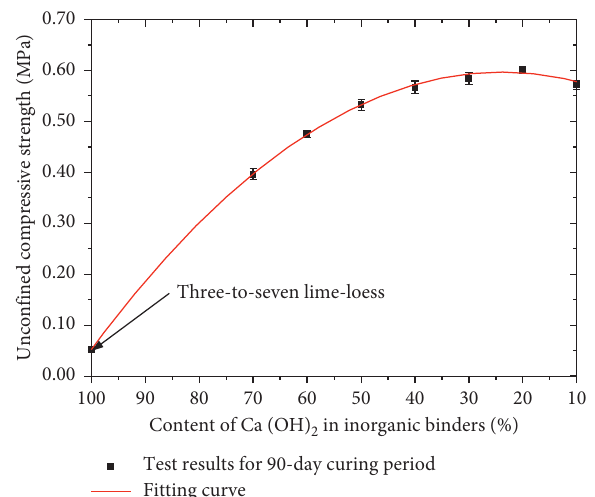
Figure 9: Influence of Ca(OH) 2 content in inorganic binders on UCS of sample during 90 d curing